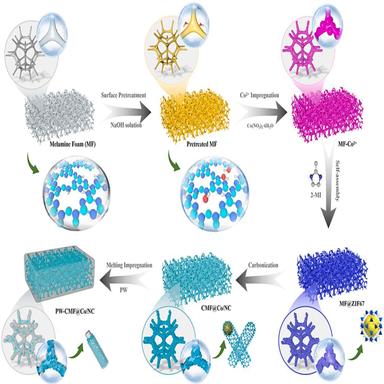
Schematic illustration of the synthesis of PW-CMF@Co/NC composite PCMs.